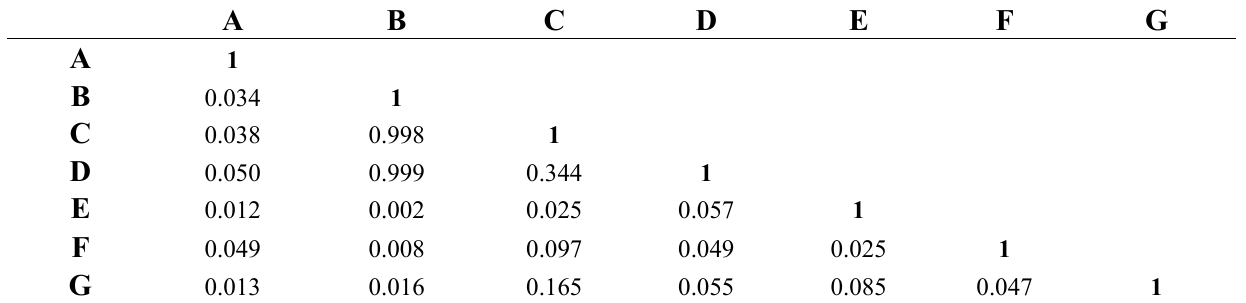
Table 3. Crammer coefficient values for the initial input variables.